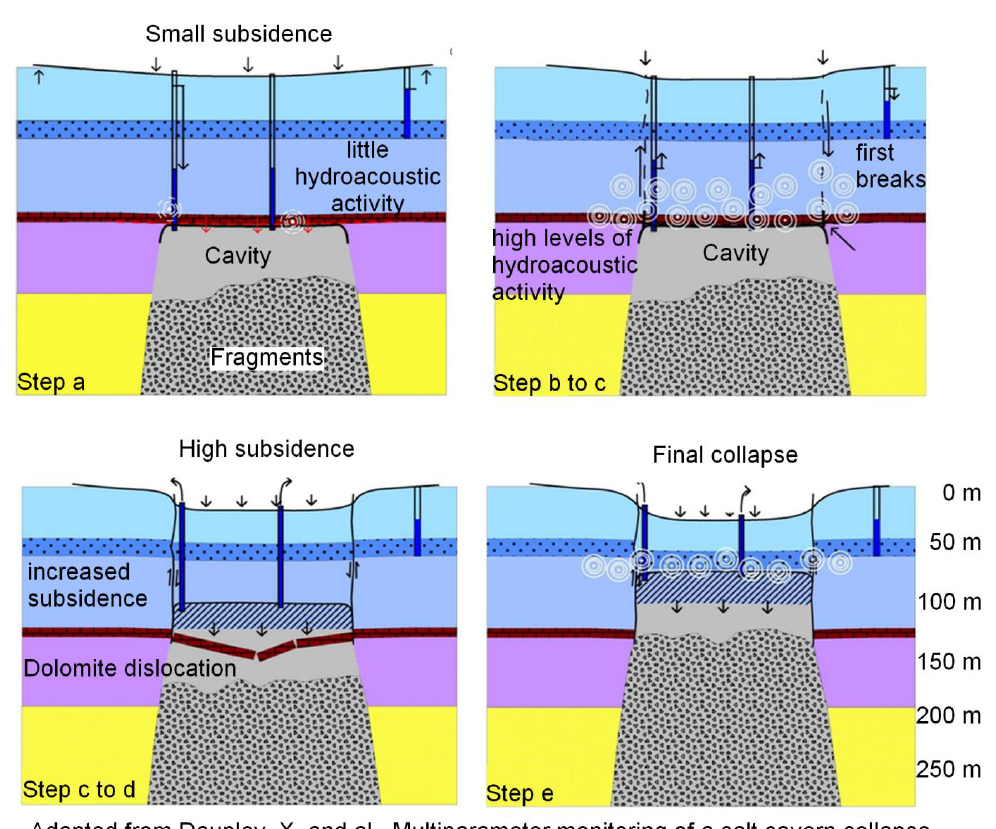
Figure B1 – Collapse mechanism 2 Fig. B1. Collapse